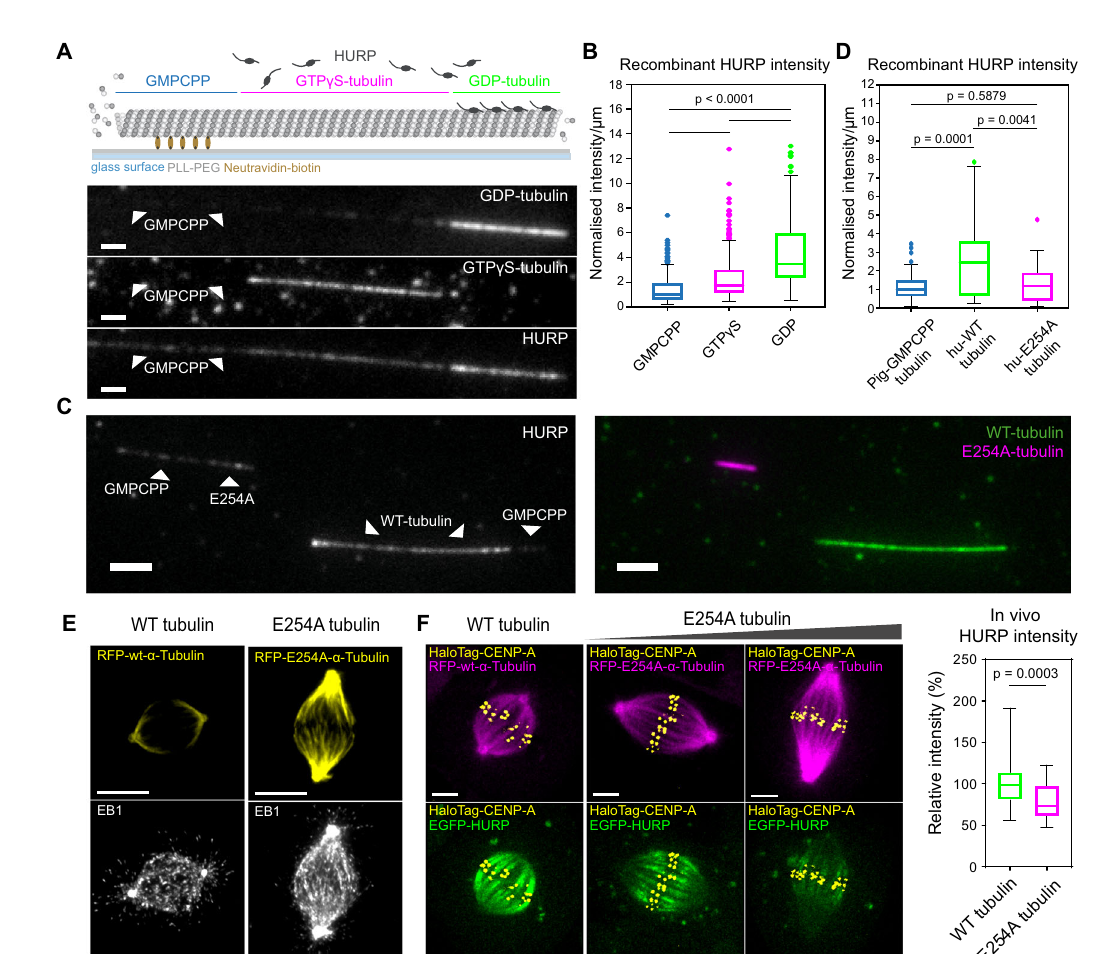
and yellow vertical dashed lines in the kymographs indicate the representative frame used for quanti fi cation at the polymerisation and depolymerisation front, respectively. D Representative images of HURP, CENP-A and EB3 signals in the hTERT-RPE1 EGFP-HURP/HaloTag-CENP-A cell line overexpressing EB3-tdTomato ( Δ T=2s).TriangleshighlightHURP-gaps. E Representativeintensitylinepro fi lesof HURP, CENP-A and EB3 signals based on live-cell imaging of hTERT-RPE1 EGFP- HURP/HaloTag-CENP-A overexpressing EB3-tdTomato ( Δ T=2s). White arrows indicate the selected axis of pro fi ling. Dark grey and blue arrows show the move- ment direction of kinetochores. Dashed lines indicate HURP-gaps. D , E Scale bars=5 µ m and 1 µ m (kymograph). Source data for all graphs are provided as a Source Data fi le.